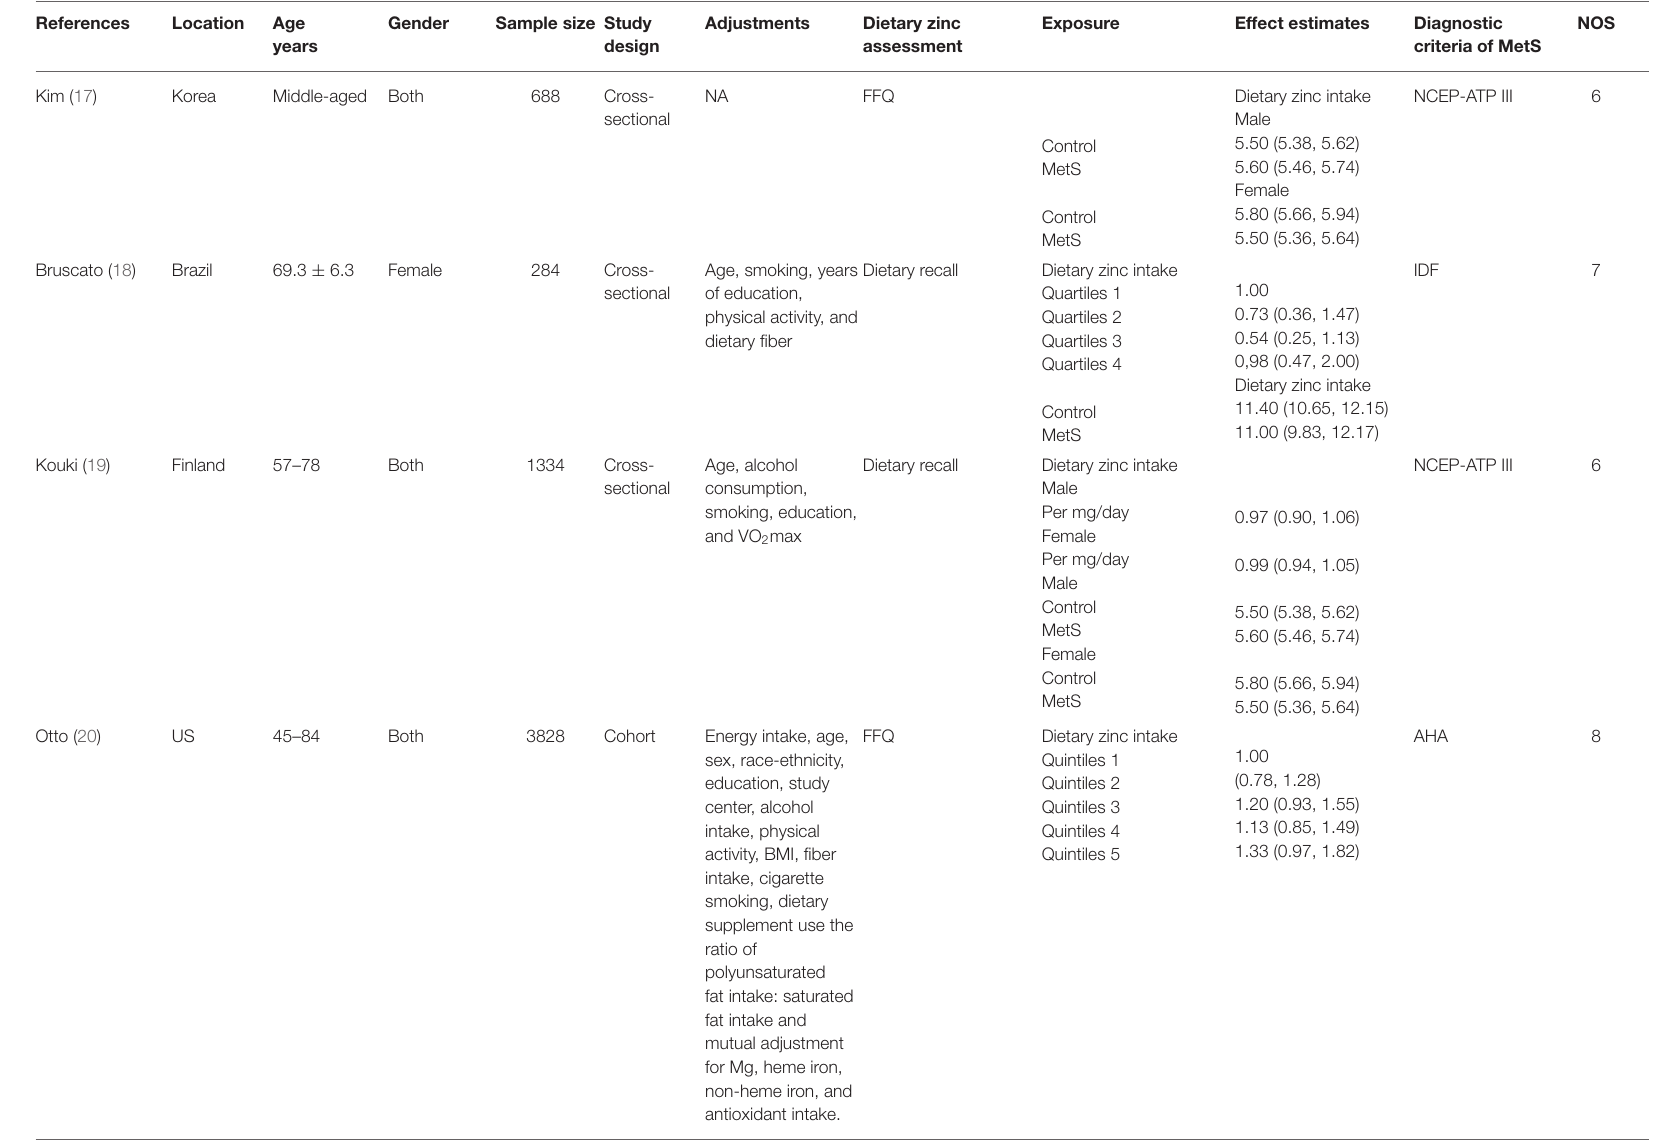
TABLE 1 | Characteristics of the individual studies included in this